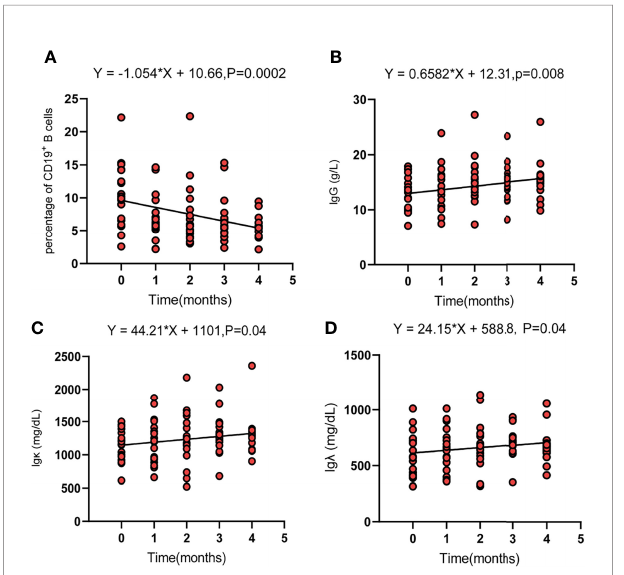
FIGURE 3 | The dynamic change trend of circulating parameters of B cells (CD19 + ) (A) , Ig G (B) , Ig k (C) , and Ig l (D) . Fit a line with simple linear regression. p < 0.05 indicates slope deviation from zero.